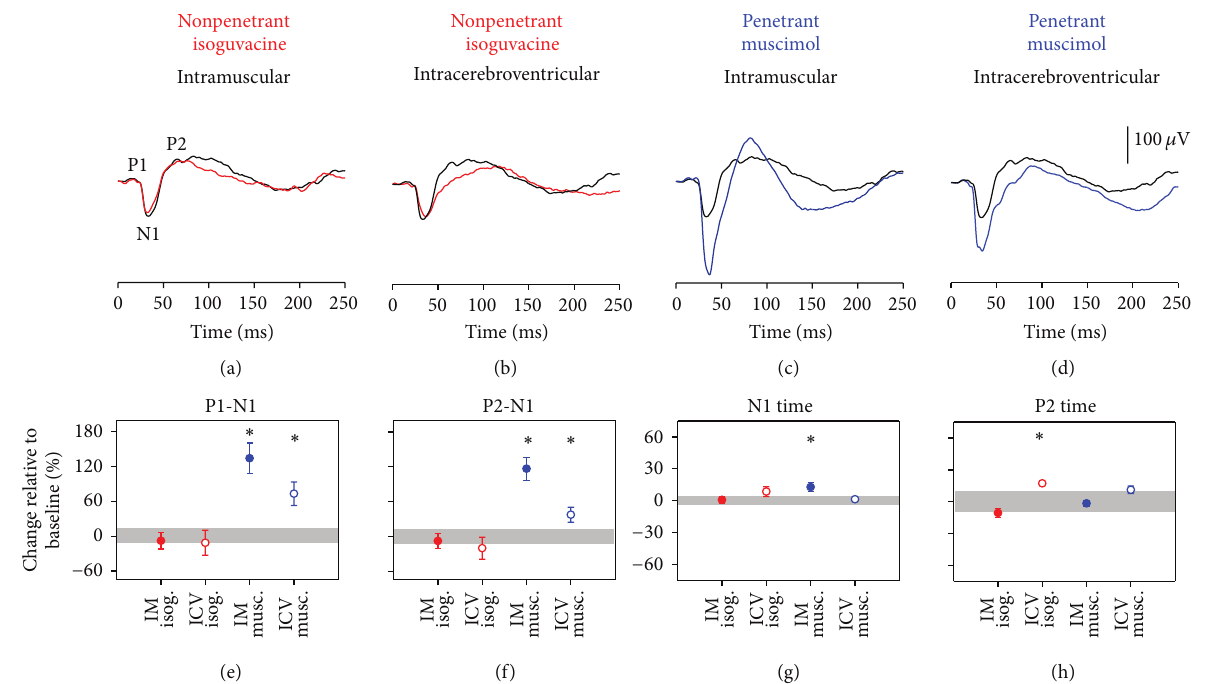
Figure 3: Cortical electrophysiology following conscious isoguvacine/muscimol injections. VEP responses in animals ((a)–(d), 𝑛 = 7 for each drug group) at conscious baseline (black lines, average of vehicle injections in conscious groups) compared to (a) intramuscular and (b) intravitreal injection of isoguvacine (red) and (c) intramuscular and (d) intravitreal injection of muscimol (blue). (e)–(h) summarise VEP parameters (average ± SEM) following isoguvacine or muscimol injections via different routes (see method for details). Grey areas indicate 95% CI of the particular VEP parameter in all conscious baseline recordings. P1, P2, and N1 are marked in (a), with P2 taken as the first positive inflection following N1. ∗ 𝑝 < 0.05